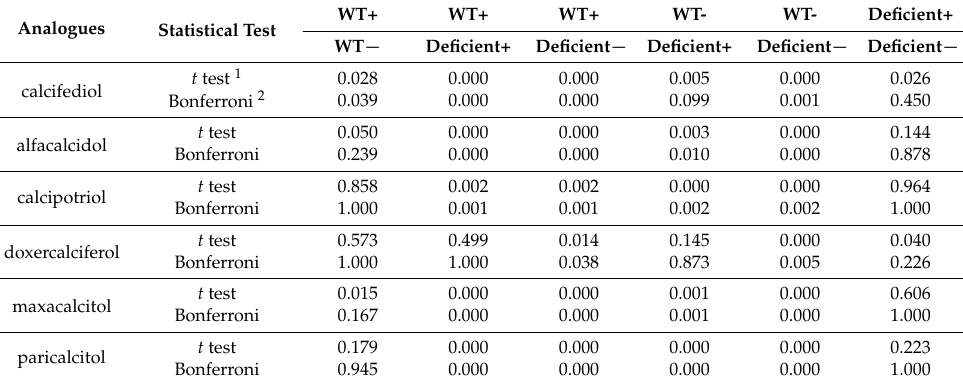
Table 1. Comparison between β -secretase activity in supplemented (WT+; 100 nM calcifediol or its analogues) and unsupplemented (WT-) wildtype mouse brains and in supplemented